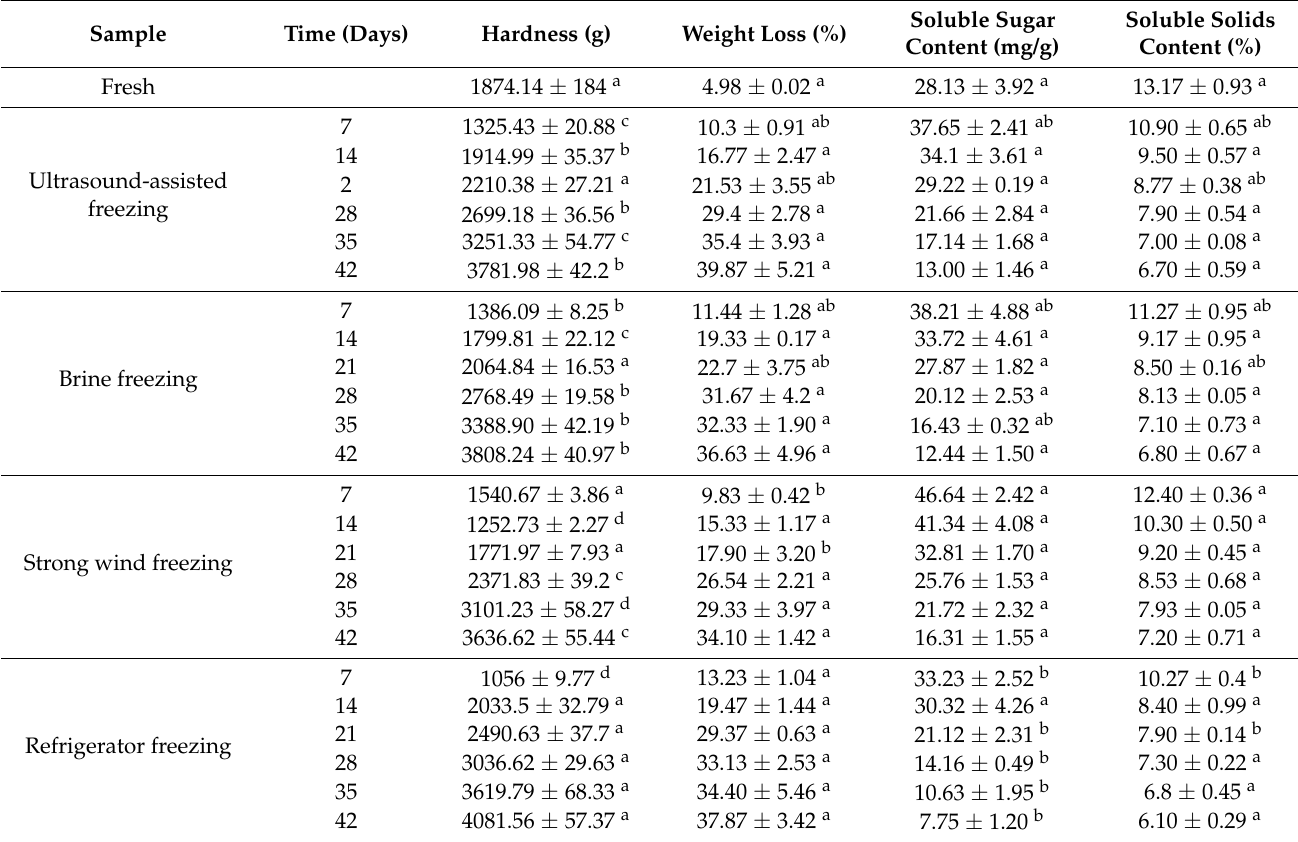
Table 2. Effect of different freezing methods on hardness, water loss, soluble sugar (c), and soluble solids content of sweet corn. Values with different lowercase letters in the same sampling are significantly different ( p <